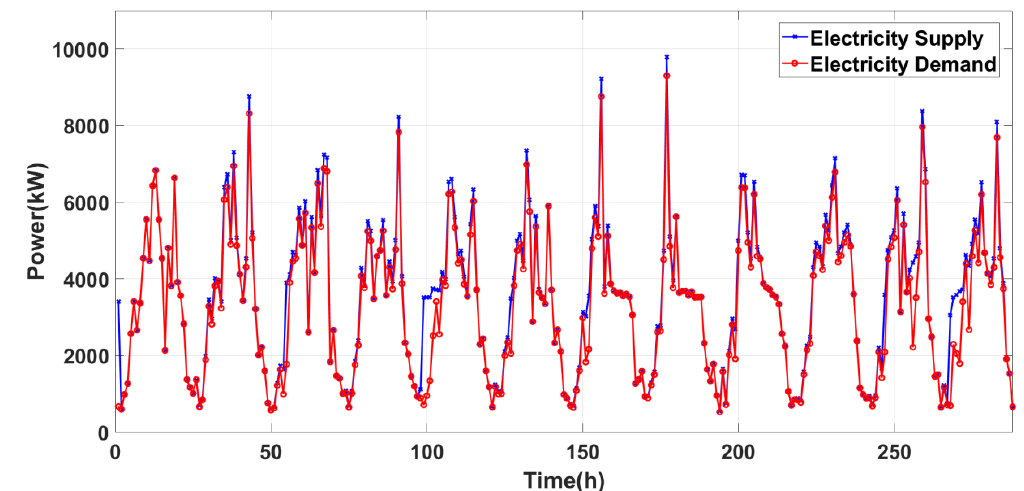
Figure 12. Electricity generation and consumption scenario of Case-01.